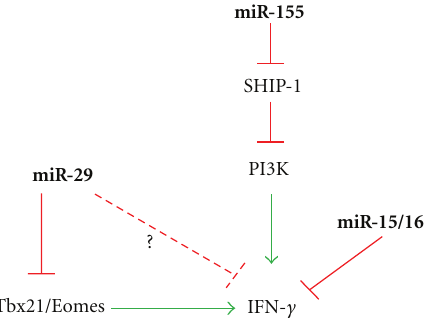
Figure 2: Summary of known miRNA interactions regulating IFN- γ or immediate upstream signals that induce IFN- γ in NK